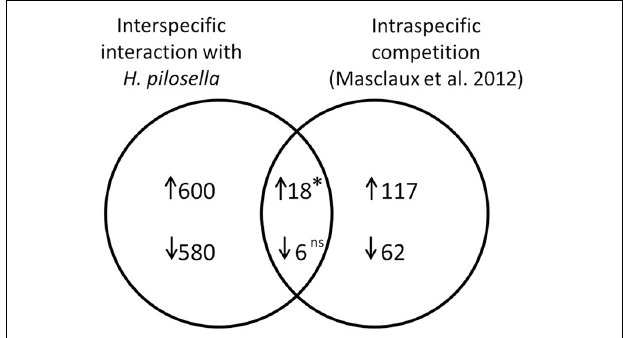
FIGURE 7 | Venn diagram with numbers of overlapping and non-overlapping differentially expressed genes in a comparison of A. thaliana roots challenged by interspecific interaction with H. pilosella (data from this paper) to A. thaliana roots challenged by intraspecific competition (Masclaux et al., 2012). Both experimental setups are additive designs (presence/absence of neighbors), while density of neighbors (if present) and impacts on biomass in examined plants is much higher in Masclaux et al. (2012). The overall number of analyzed transcript IDs (mutually utilized in both studies) was N = 13150. ↑ , induced genes; ↓ , repressed genes. The asterisk indicates a significantly higher value than numerical expectation from a 2 ∗ 2table (cf. Nemhauser et al., 2006) with ∗ p < 0 . 05 in Chi 2 -Test; ns, not